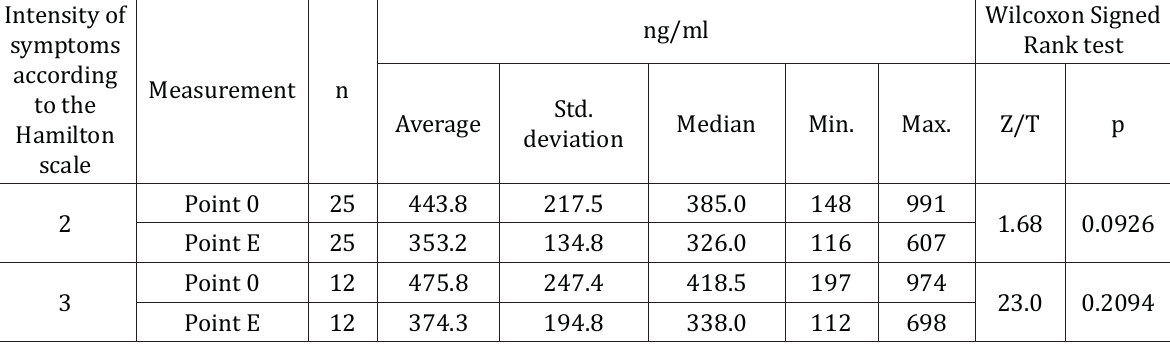
Table 8. Descriptive statistics – Concentration of MMP-9 in patients with differing intensities of symptoms according to the HDRS at two points in time and the results of a Wilcoxon Signed Rank test